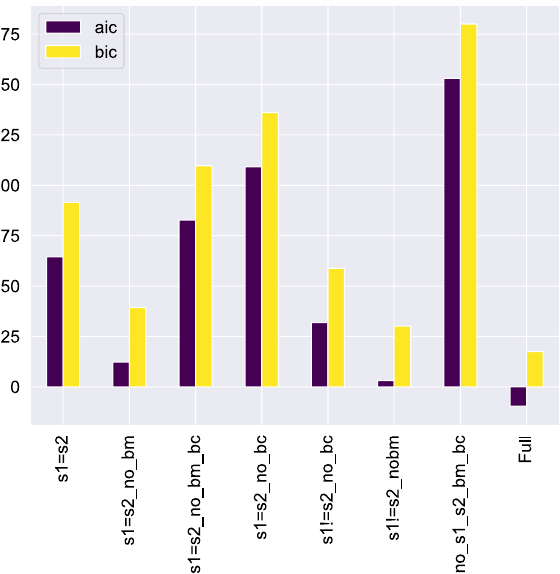
Figure 7. Collective Akaike Information Criterion (AIC) and Baeysian Information Criterion (BIC) for the Full Z-model and its seven variants. The Full Z-model has clearly the lowest AIC and BIC among all variants studied.